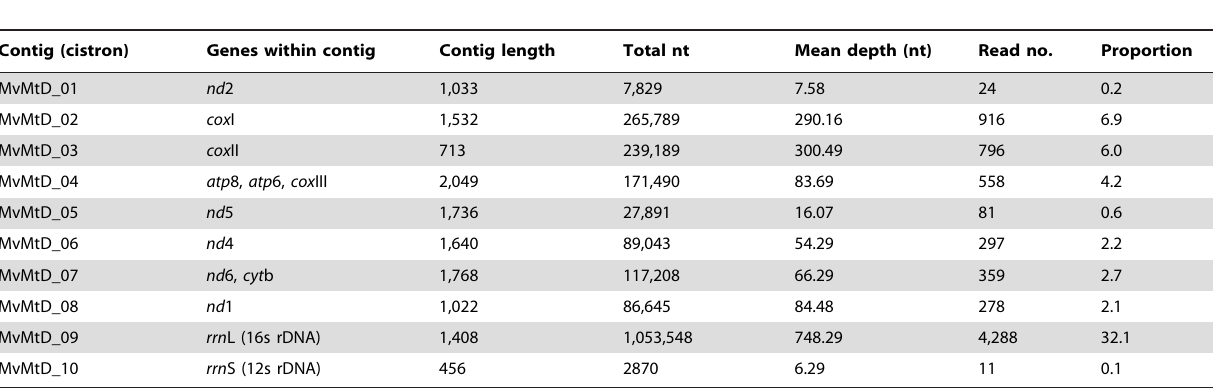
Table 4. The quantitative expression profile of cistrons transcribed from Maruca vitrata mitochondrial genome.